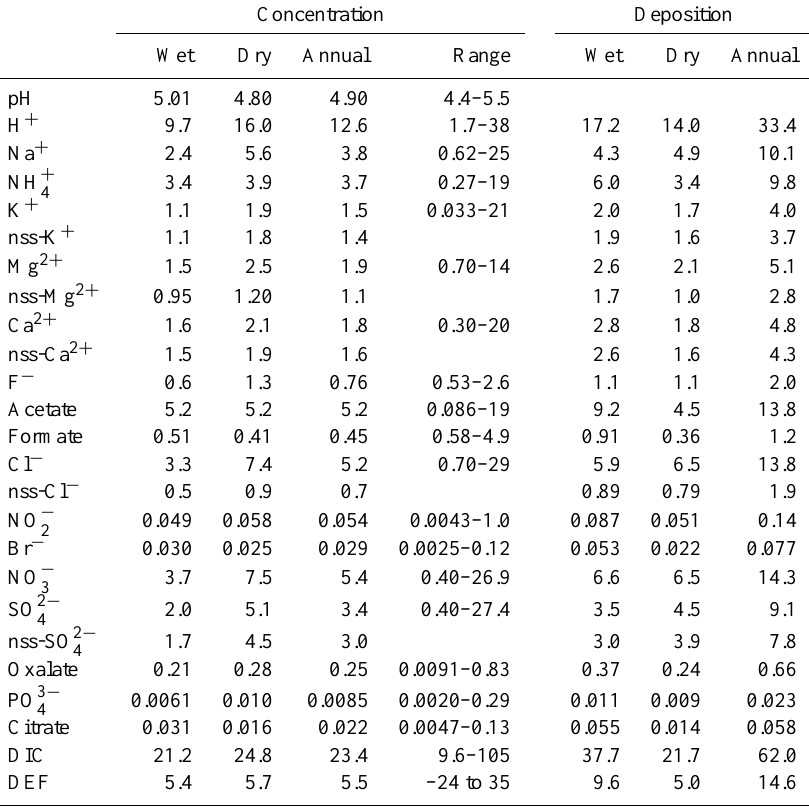
Table 5. Volume Weighted Mean (VWM) concentrations and deposition rates observed in rainwater at Balbina. Results area shown separately for wet and dry seasons and annual mean. The range column refers to minimum and maximum observed concentration observed in the collected samples. Concentrations are expressed in µeql − 1 (except for DIC expressed in µml − 1 ) , and deposition rates in µeqm − 2 (µMm − 2 )